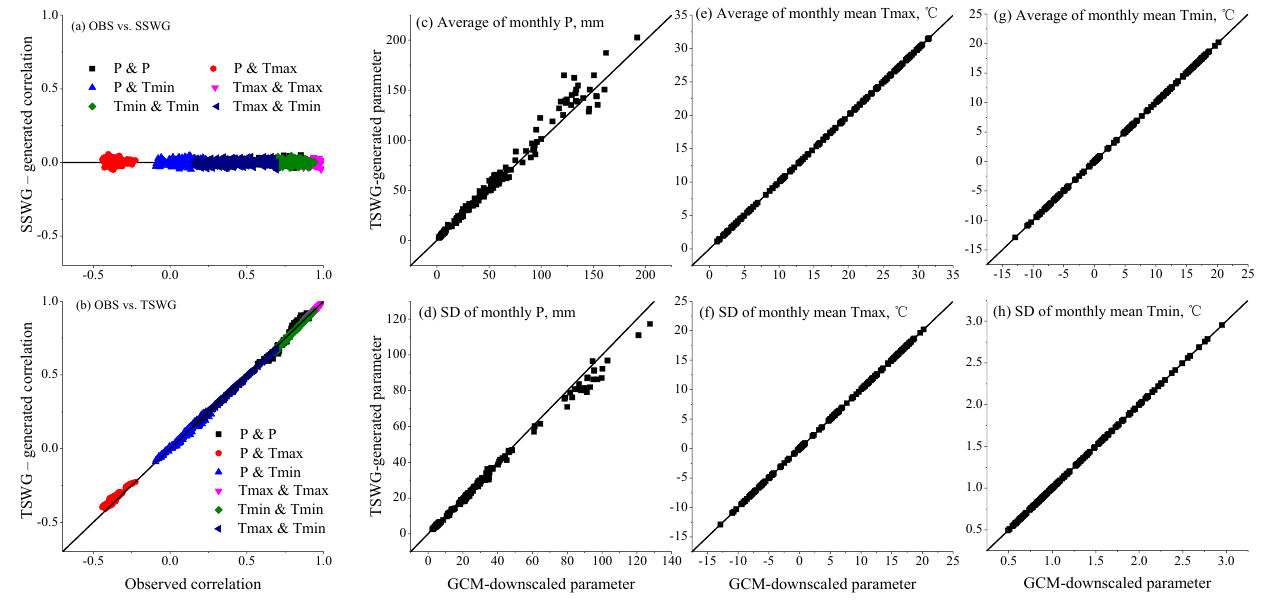
Figure 4. (a) and (b) Observed (OBS) versus generated multisite and multivariate correlations of daily precipitation ( P ), maximum temper- ature ( T max ) , and minimum temperature ( T min ) . (c) – (h) Average and standard deviations (SD) of monthly P , T max , and T min